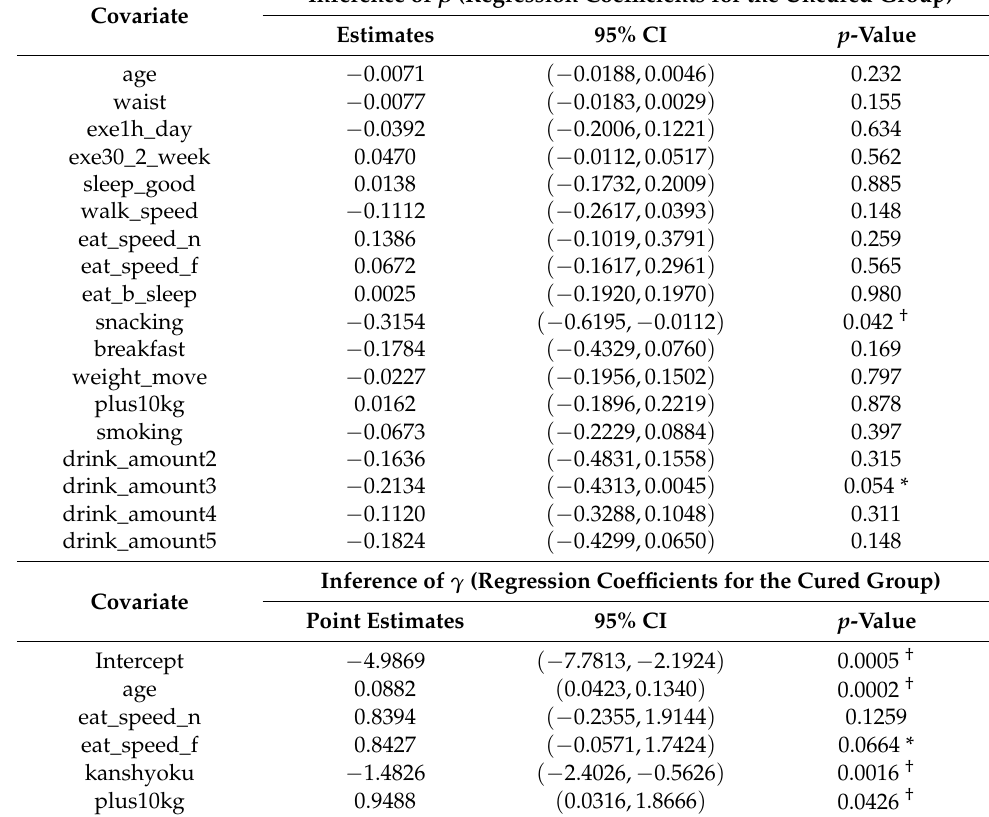
Table 6. Estimation result of regression coefficient when variable selection is performed by applying the proposed model in males. CI is the confidence interval. The asterisk (*) and dagger (†) indicate that p -value is less than 0.10 and 0.05, respectively.